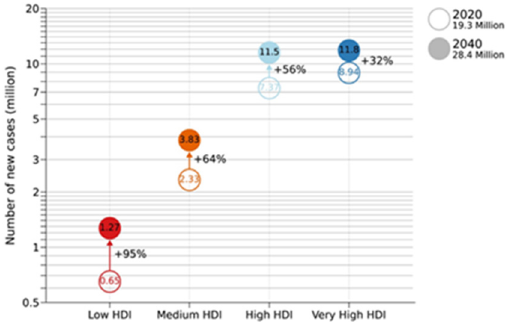
Figure 1. Projected number of new cancer cases in 2040 according to the 4-Tier Human